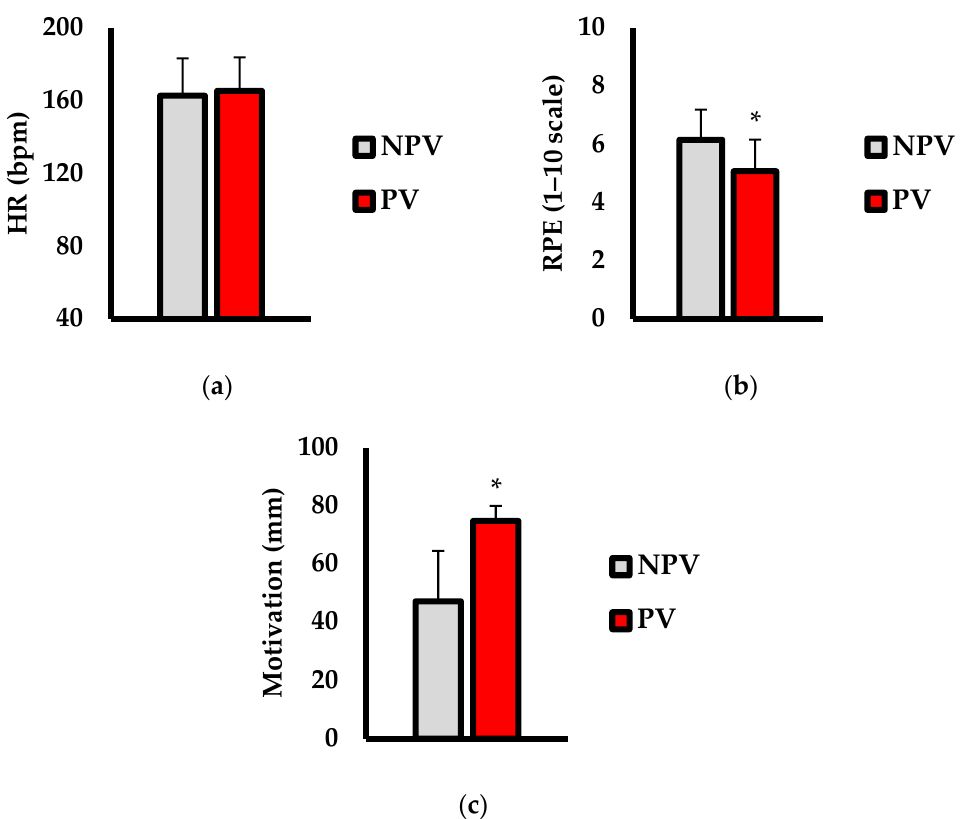
Figure 3. Comparisons of ( a ) heart rate (HR; bpm), ( b ) rate of perceived exertion (RPE; 1–10 scale), and ( c ) motivation to exercise (mm) between non-preferred volume (NPV) and preferred volume (PV) conditions. Data are presented as mean ± SD. * indicates significantly different than NPV ( p < 0.05).